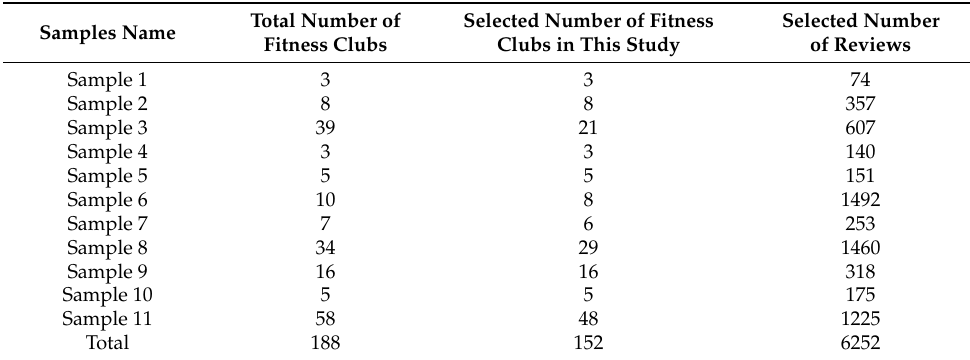
Table 1. Survey Samples in Dazhong Dianping in